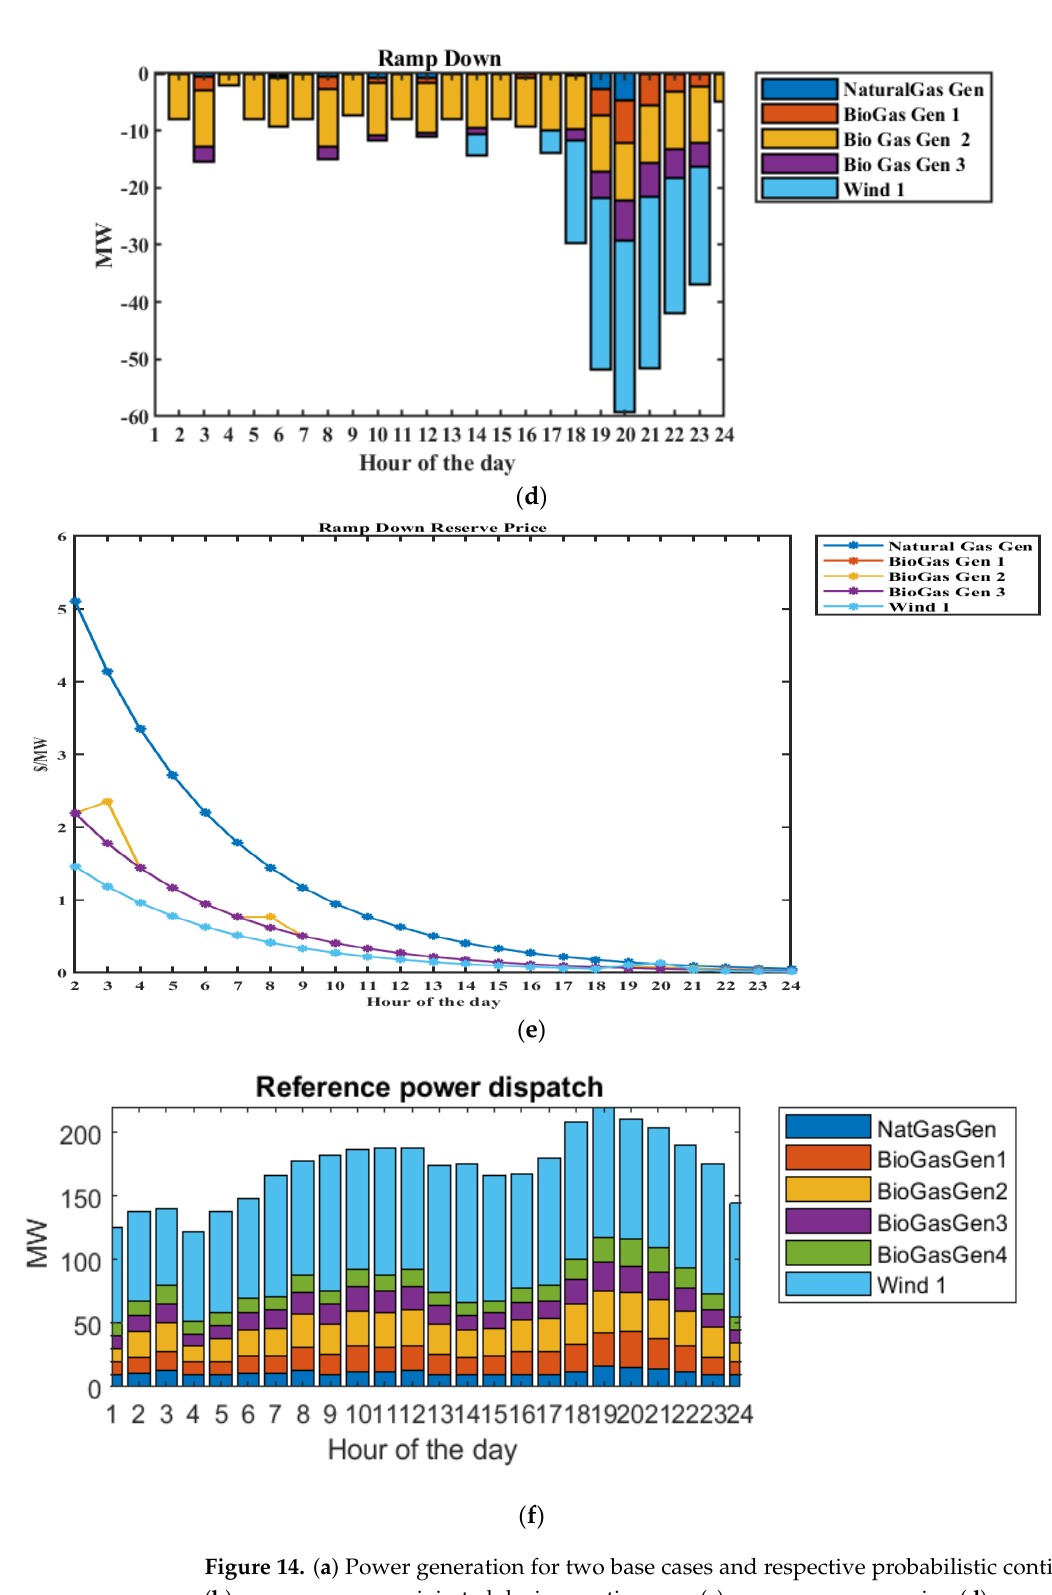
Figure 14. ( a ) Power generation for two base cases and respective probabilistic contingency cases, ( b ) ramp-up reserves injected during contingency, ( c ) ramp-up reserve price, ( d ) ramp-down reserve injected during contingency, ( e ) ramp-down reserve price, and ( f ) reference power dispatch during contingency.